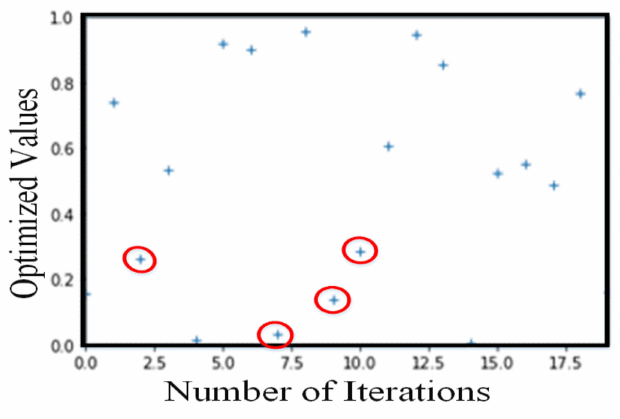
Figure 6. Optimized